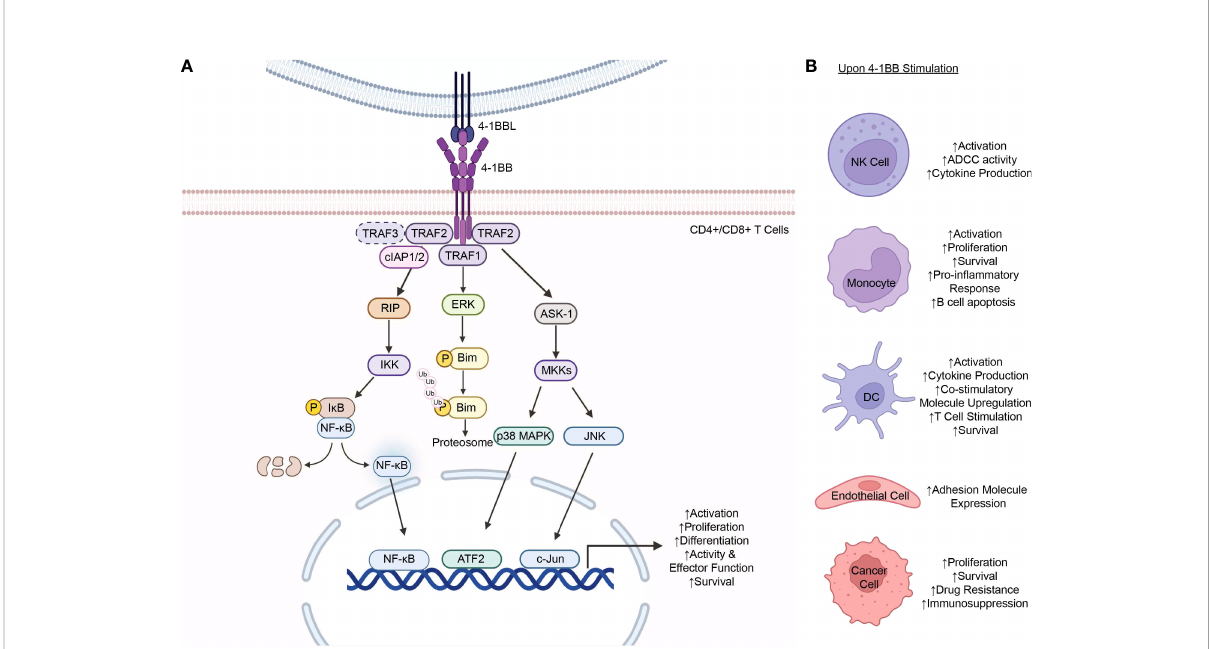
FIGURE 1 4-1BB Expression and Signaling. (A) 4-1BB stimulation on T cells results in the activation of multiple signaling pathways downstream the receptor. Upon interaction with 4-1BBL and subsequent activation, 4-1BB signaling is initially mediated by the recruitment of TRAF1, TRAF2, or, hypothetically, TRAF3 (in dashed lines), to the TRAF-binding motif located in the 4-1BB cytoplasmic tail. The TRAF proteins form a homo- or hetero-trimer and, in turn, recruits cIAP1/2 which further mediates the activation of downstream effectors that transduce signals down various signaling cascades to the nucleus including the NF- k B, ERK, p38 MAPK, and JNK pathways. Signaling down these pathways results in the increased expression of the anti-apoptotic proteins, B fl -1 and Bcl-x L , decreased expression of the pro-apoptotic protein Bim, and increased proliferation, differentiation, effector functions, and survival of the T cells. (B) 4-1BB expression is observed in a wide range of cells including NK cells (4, 35), monocytes (36 – 38), DCs (11, 39, 40), endothelial cells (14, 41), and malignant cancer cells (16, 42 – 44). Stimulation of 4-1BB on the respective cells result in varying cellular responses depending on the cell type. TRAF, tumor necrosis factor receptor-associated factor; cIAP, cellular inhibitor of apoptosis protein; RIP, receptor interacting protein; IKK, I k B kinase; I k B, inhibitor of NF- k B; NF- k B, nuclear factor-kappa B; ERK, Extracellular Signal-Regulated Kinase; Bim, Bcl-2-like protein 11; ASK-1, apoptosis signal-regulating kinase 1; MKK, Mitogen-Activated Protein Kinase Kinase; MAPK, mitogen-activated protein kinases; JNK, Jun N-terminal kinase; ATF2, activating transcription factor 2; P, phosphate; Ub, ubiquitin; NK cell, natural killer cell; ADCC, antibody-dependent cellular cytotoxicity; DC, dendritic cell; B fl -1, Bcl-2-related protein A1; Bcl-x L , B cell lymphoma-extra large. The fi gure was created with